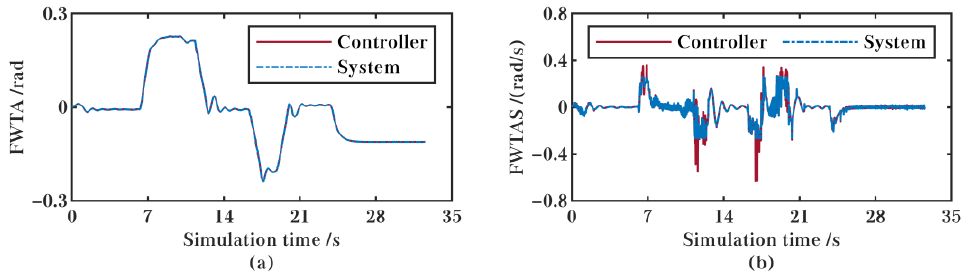
Figure 16. The front wheel turning angle and the front wheel turning angle speed of the simulation when tracking the complex reference path: ( a ) FWTA; ( b ) FWTAS.